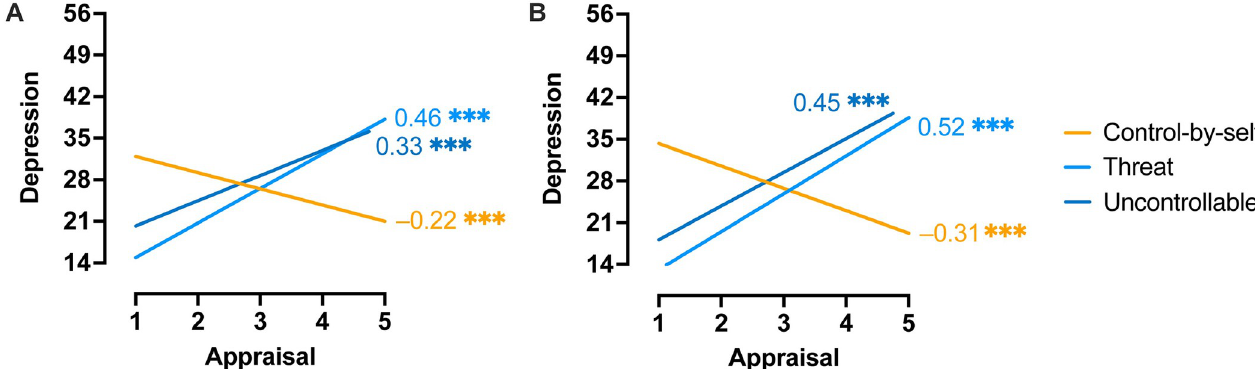
Fig 2. Appraisals of stressful situations predicted feelings of depression. Relationship between threat (light blue), uncontrollable (dark blue), and controllable-by-oneself (orange) appraisals at Time 1 ( A ) and Time 2 ( B ) with depression at Time 2. Lines on the plot represent simple linear regressions, and numerals represent bivariate Pearson correlations, r: ��� , p <